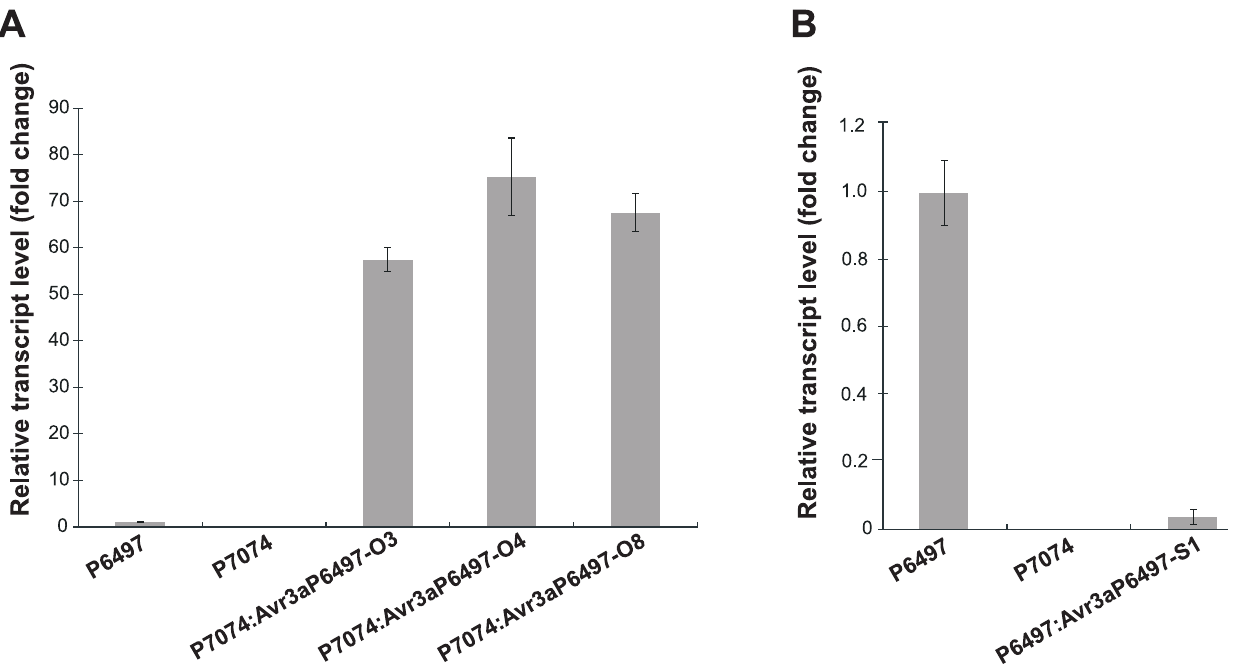
Figure 4. Expression levels of Avr3a in wild-type and transgenic strains of P.sojae . (A) Relative expression of Avr3a in mycelia cultures of wild-type strains P6497 and P7074, and transgenic over-expressing strains P7074:Avr3a P6497 -O3, P7074:Avr3a P6497 -O4, and P7074:Avr3a P6497 -O8. Expression was measured by quantitative real time PCR and normalized to the level in wild-type P6497. (B) Relative expression of Avr3a in mycelia cultures of wild-type strains P6497 and P7074, and transgenic silenced strain P6497:Avr3a P6497 -S1. Expression was measured by quantitative real time PCR and normalized to the level in wild-type P6497. Bars indicate standard errors from three independent replicates.